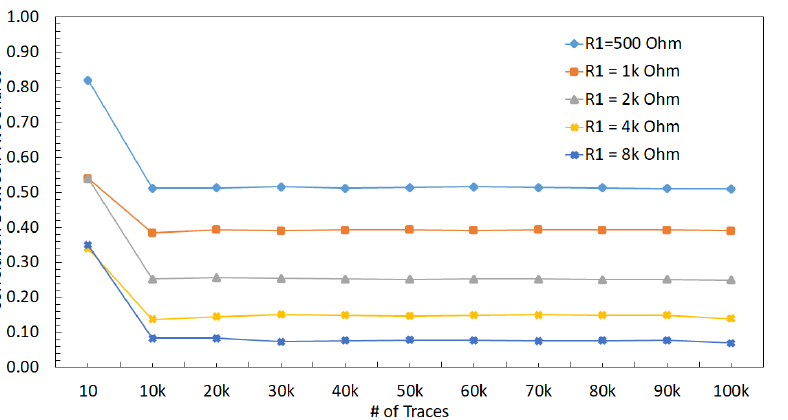
Figure 16. Correlation between V 1 and V 2 when R1 is changed from 500 Ω to 8 K Ω when a strong DLDO is used as the voltage regulator.